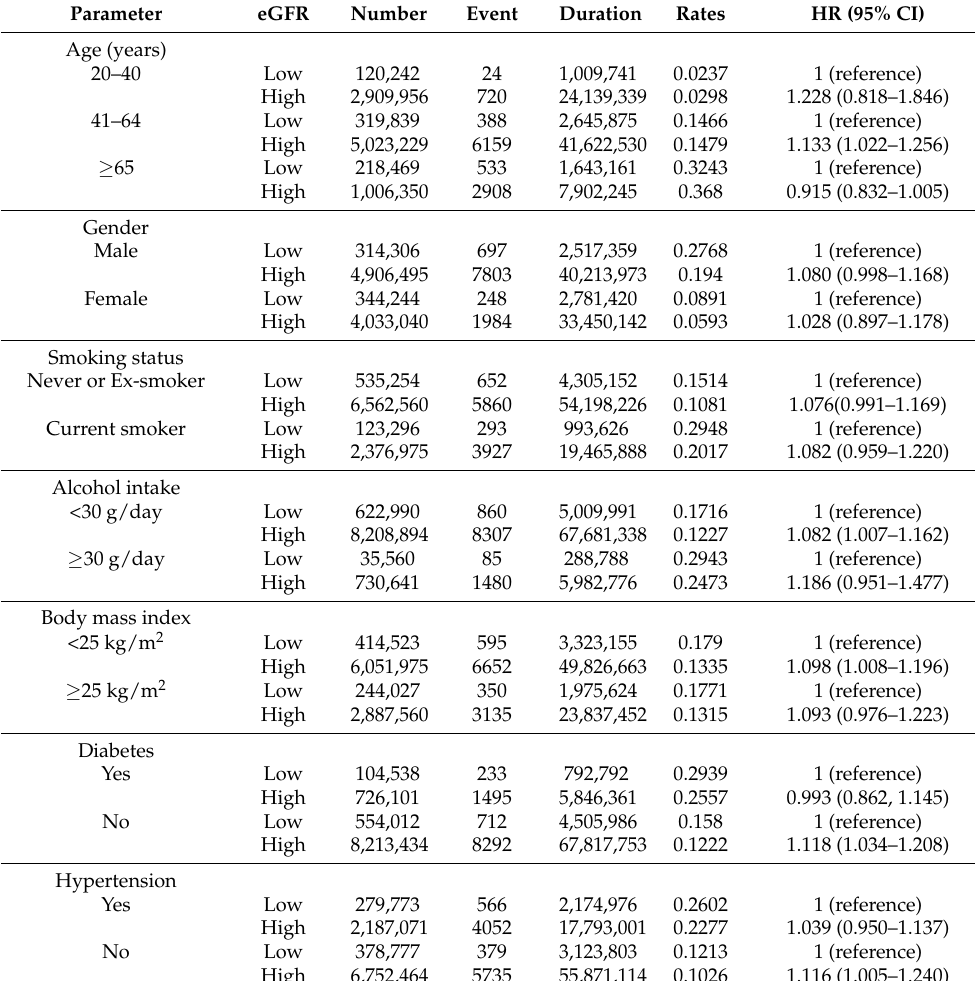
Table 3. Analysis of factors potentially associated with head and neck cancer according to the estimated glomerular filtration